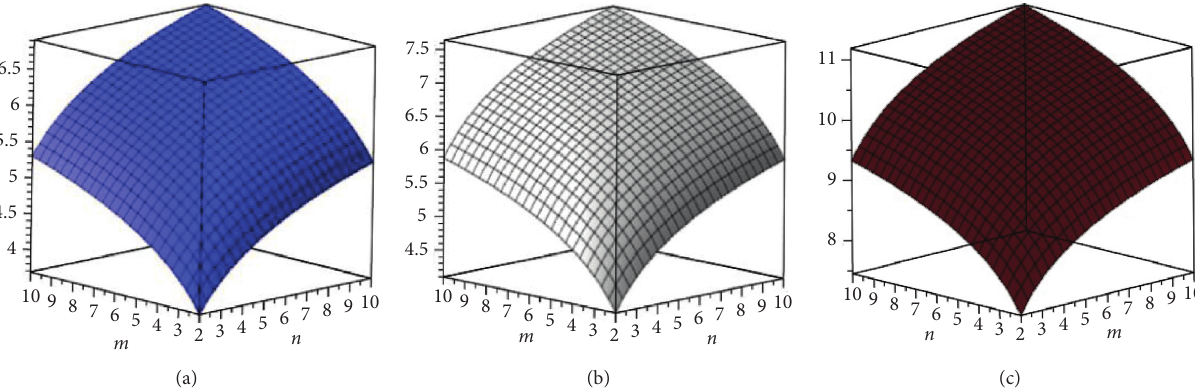
Figure 19: (a) The redefined first Zagreb entropy; (b) the redefined second Zagreb entropy; (c) the redefined third Zagreb entropy.